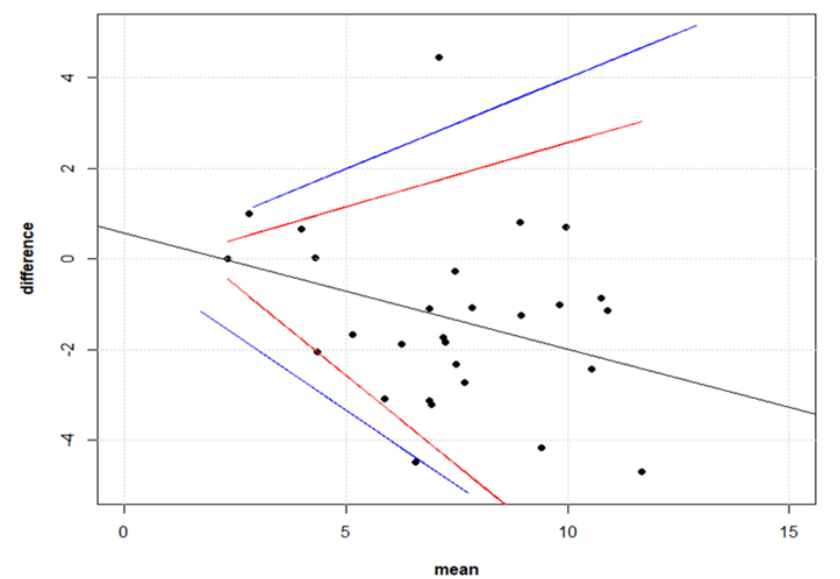
Figure 6. Bland–Altman plot. The Bland–Altman plot evaluating PNT-MNT agreement. The maximum acceptable di ff erences (blue lines) embrace the LOAs (red lines), which makes the interpretation